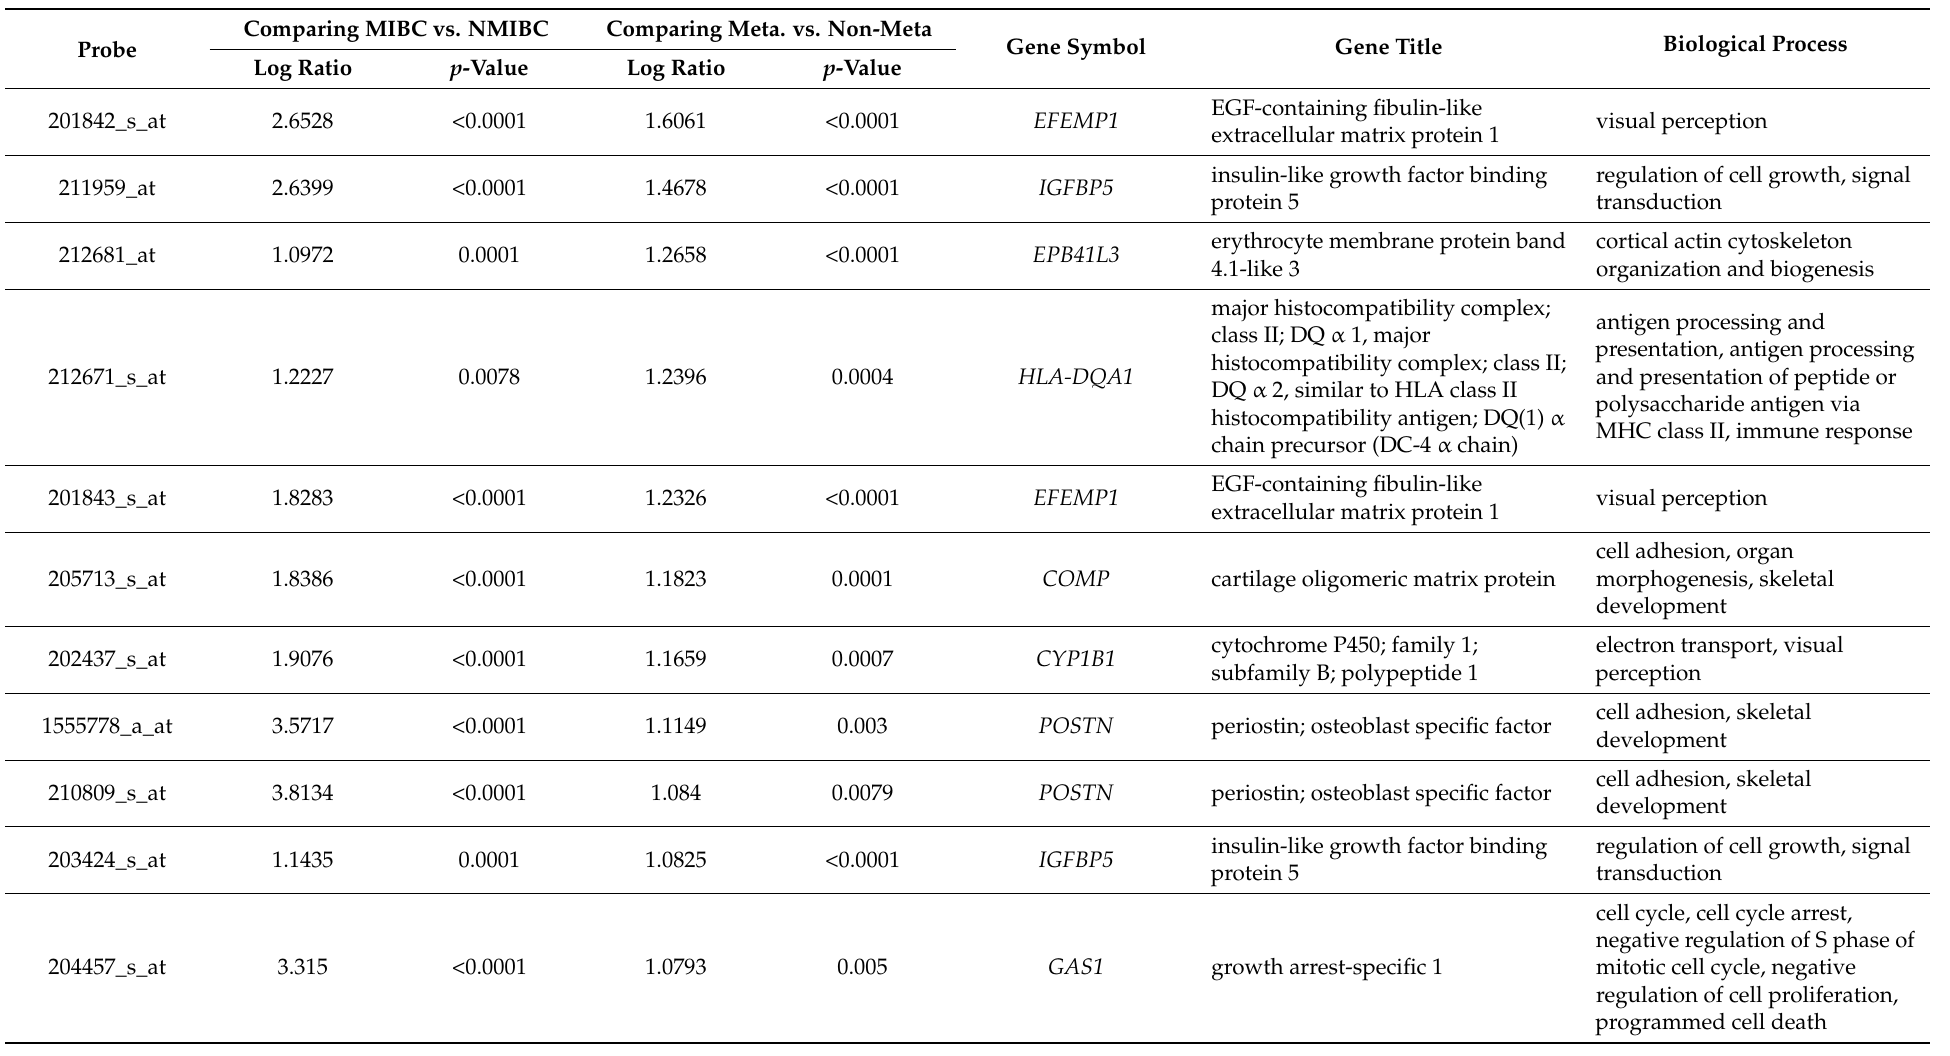
Table 1. Summary of top 10 upregulated genes associated with muscle invasion and the development of distant metastasis in UC (GSE31684).